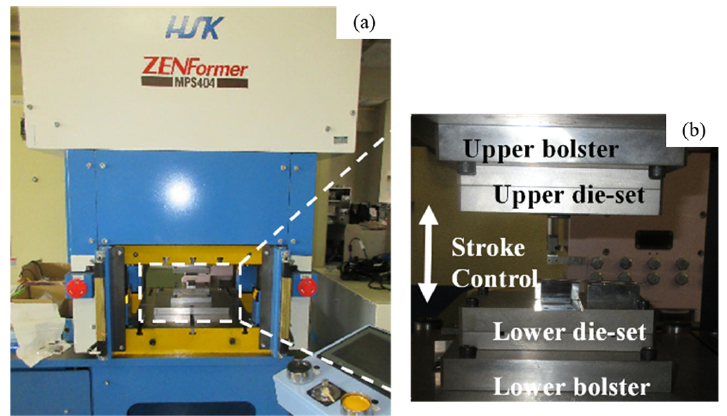
Figure 1. CNC-forging system for upsetting of the titanium and titanium alloy wires: ( a ) press machine; and ( b ) schematic view of forging die.